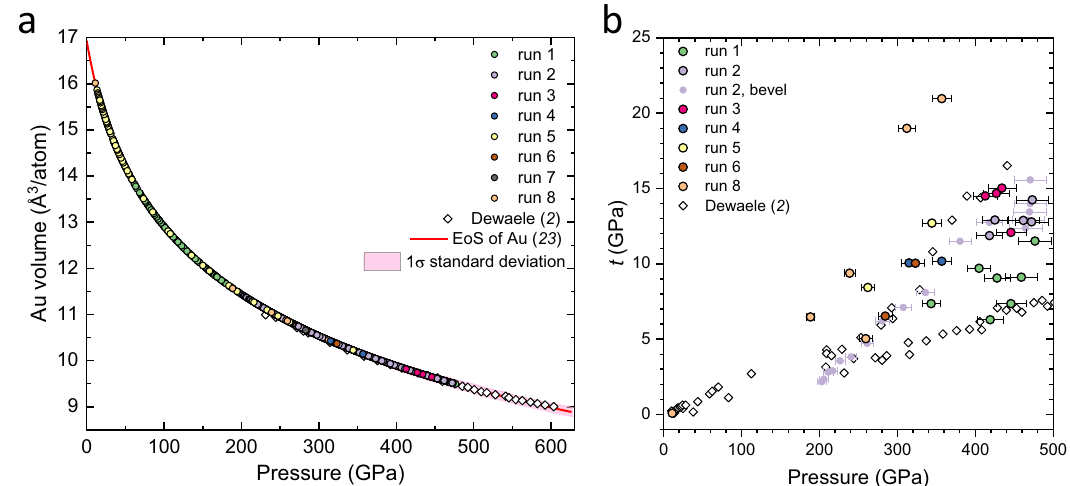
Fig. 3 | X-ray diffraction measurements for the diamond edge Raman scale. a Lattice volume of gold vs pressure measured in runs 1 – 8. Pressure values were estimatedfromtheisothermobtainedfromtherampcompression 23 .Magentaarea correspondsto1 σ standarddeviation. b Uniaxialstress t sustainedbygoldsamples in runs 1 – 6 and 8. Large colorful circles with black edges correspond to values of uniaxial stress calculated at the highest pressure in each compression cycle. Small